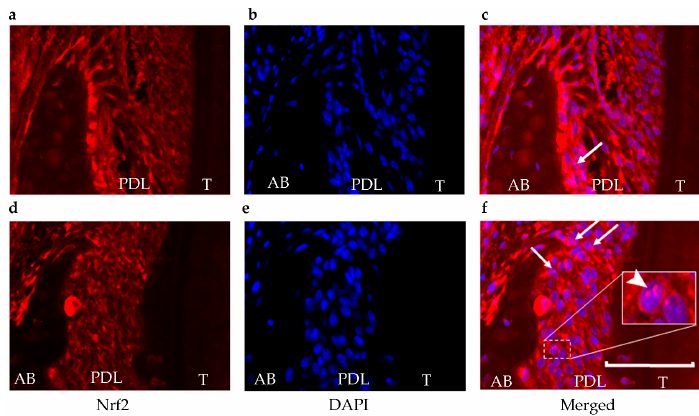
Figure 4. Translocation of Nrf2. For the Nrf2 nuclear translocation assay, the nuclear level of Nrf2 was determined using immunofluorescence staining ( red ) ( a , d ). The cell nuclei were visualized by DAPI staining ( blue ) ( b , e ). In the control group, Nrf2 expression was observed ( a ), but there was less translocation ( c ) than in the periodontitis group ( f ). Arrows show cells that are positive for both Nrf2 and DAPI in the nucleus. The arrowhead in white box shows a magnification of an area of cells with positive staining for both Nrf2 and DAPI in the nucleus. These double-positive cells mainly existed adjacent to the alveolar bone surface within the periodontal ligament. 4’,6-diamidino-2-phenylindole, DAPI; AB, alveolar bone; PDL, periodontal ligament; T, tooth. Scale bar = 50 µm. In the periodontitis group, HO-1-positive cells were observed in areas adjacent to the alveolar bone surface within the periodontal ligament at day 7. The ratio of HO-1-positive cells was significantly higher in the periodontitis group than in the control group ( p < 0.05) (Figure 5).